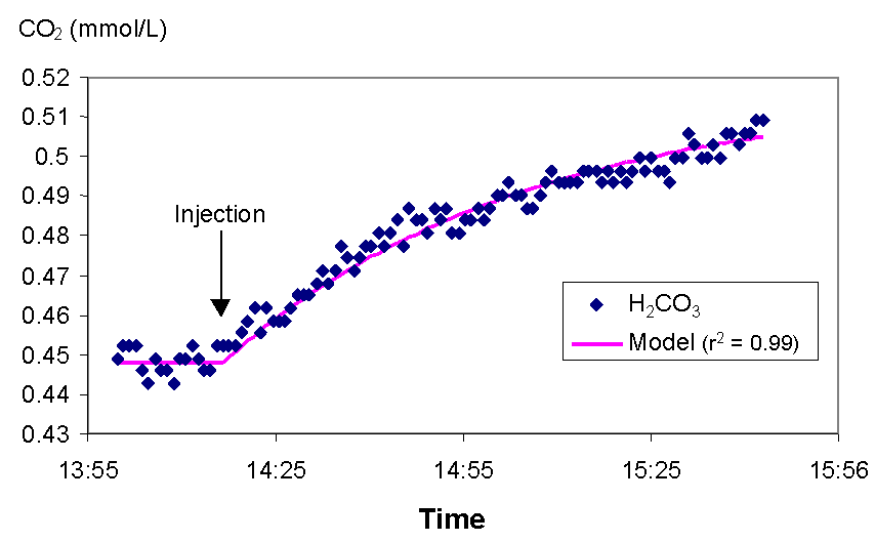
FIGURE 5. Degradation of fuel mixture in the experimental apparatus. The equivalent of 1 mg/l (or approx. 0.077 mmol/l of organic C) of fuel was injected. CO 2 is given in mmol/l, as measured in gas phase equilibrated with recirculating water, time in hours. The vertical arrow shows the time of injection of the fuel